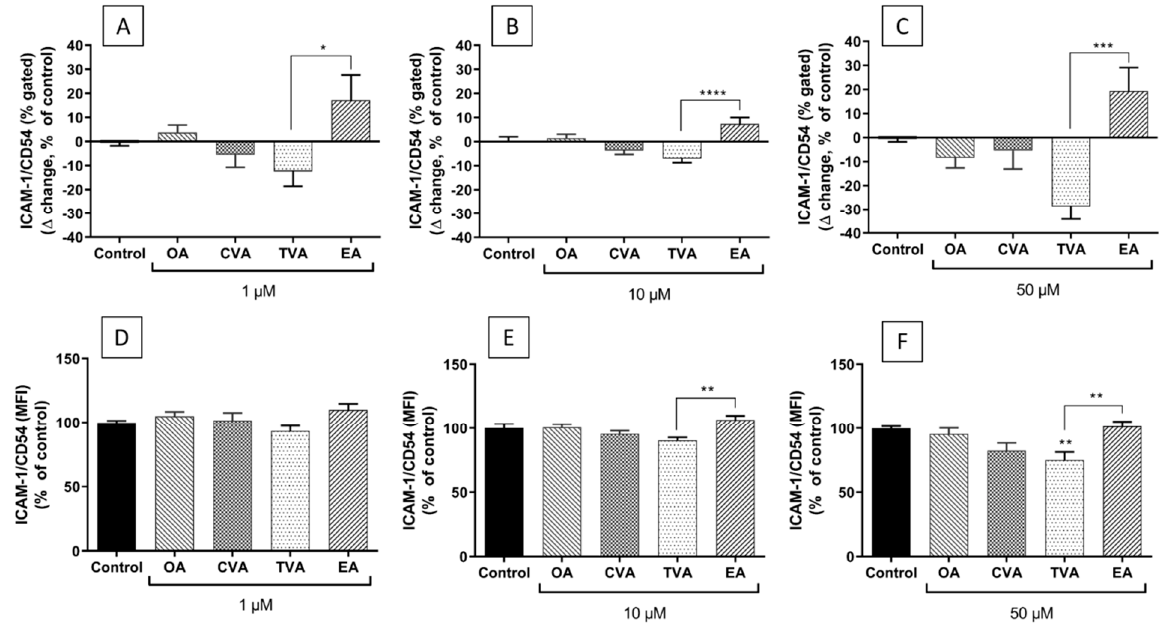
Figure 9. Cell surface expression of ICAM-1 as % of EA.hy926 cells gated ( ∆ change, % of control) ( A – C ) and as median fluorescence intensity (MFI, % of control) ( D – F ) after preincubation for 48 h with DMEM containing 0.1% ethanol (Control) or different concentrations (1 μ M; 10 μ M; 50 μ M) of FA, followed by incubation with TNF- α (1 ng/mL) for 6 h. Bars are mean ±SEM of 9 samples performed in 3 experiments. Data were analysed using one-way ANOVA with Tukey’s post hoc test. * p < 0.05; ** p < 0.01; *** p < 0.001, **** p < 0.0001 between groups indicated by joined lines or vs. Control when there is no joined line. OA = oleic acid, CVA = cis vaccenic acid, TVA = trans vaccenic acid, EA = elaidic acid.